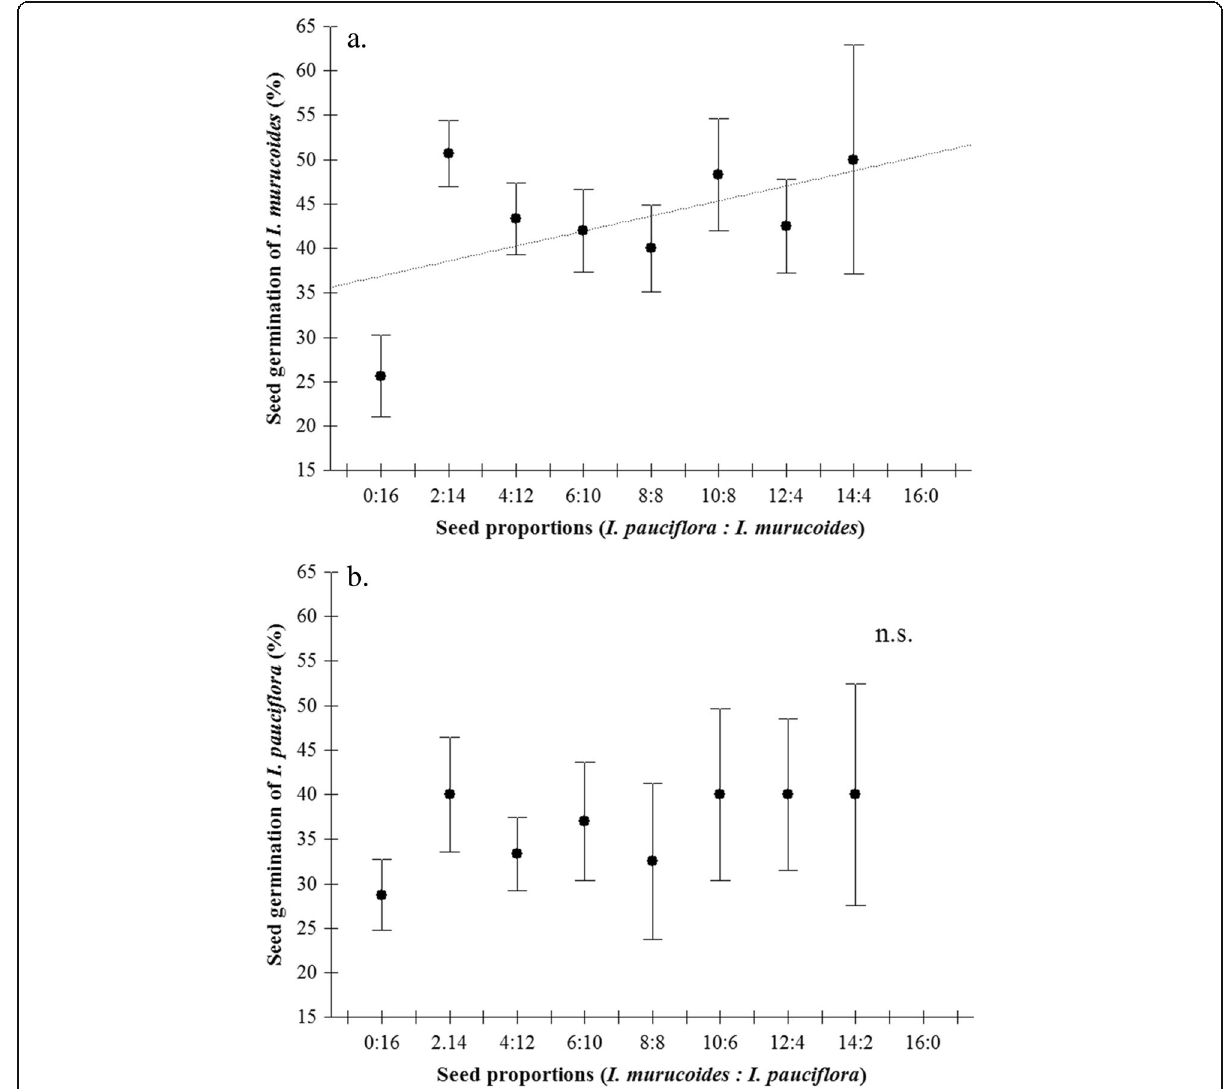
Fig. 1 Percentage of germination in vitro (mean ± SE) of seeds of a Ipomoea murucoides in response to seed proportions of I . pauciflora : I . murucoides and of b I . pauciflora in response to seed proportions of I . murucoides : I . pauciflora . n.s. = not